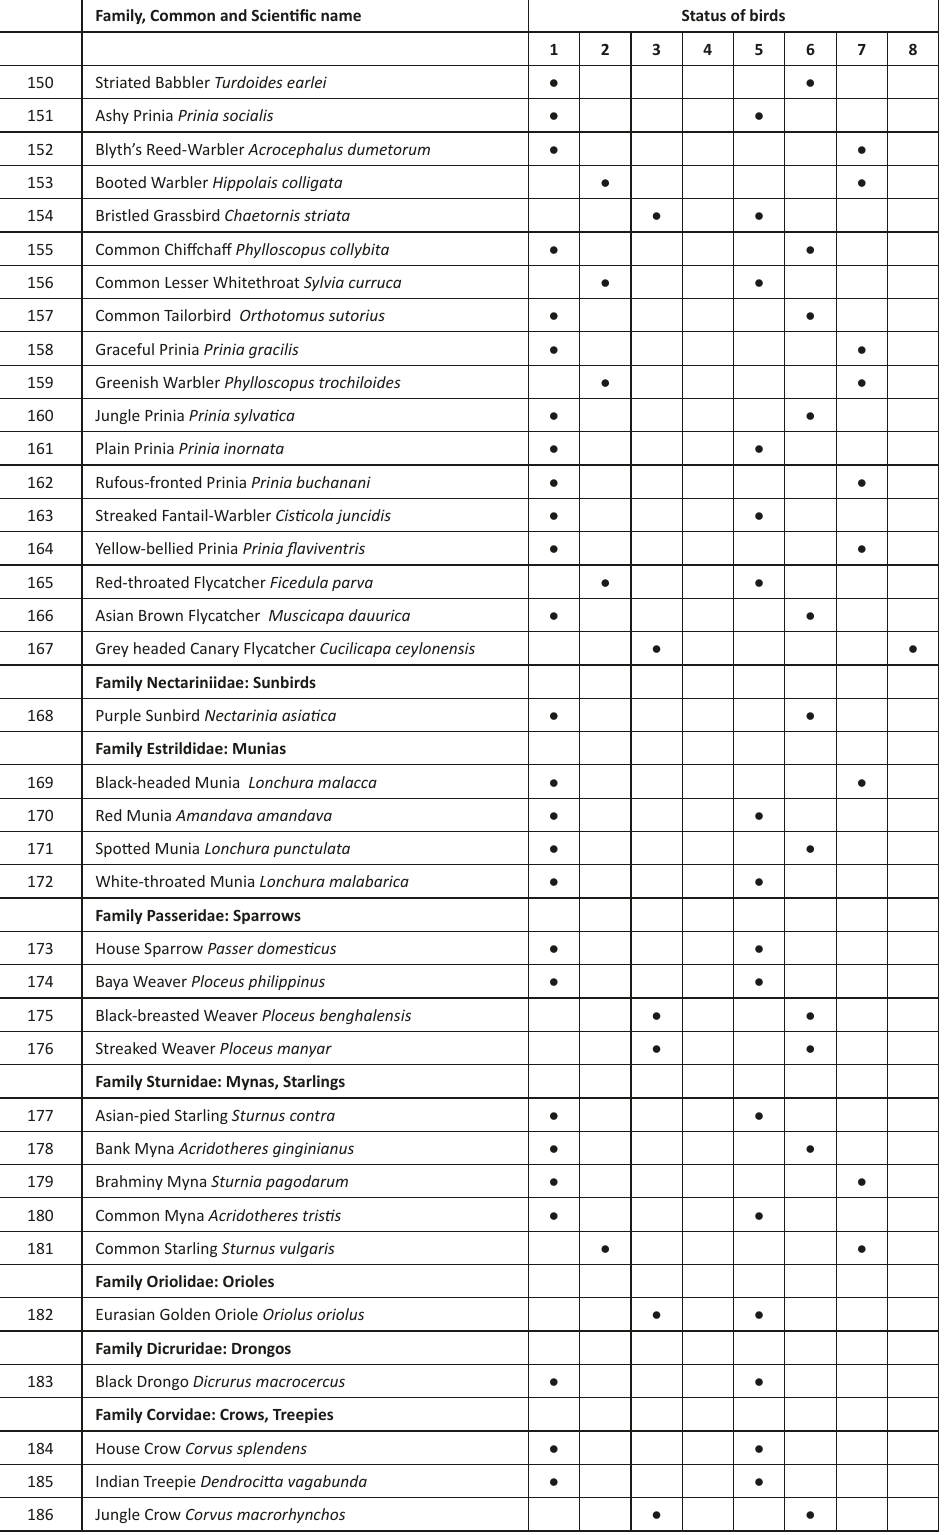
Footnote: 1 - Resident; 2 - Winter Migrant; 3 - Summer Migrant; 4 - Passage migrant; 5 - Common; 6 - Fairly Common; 7 - Uncommon; 8 -